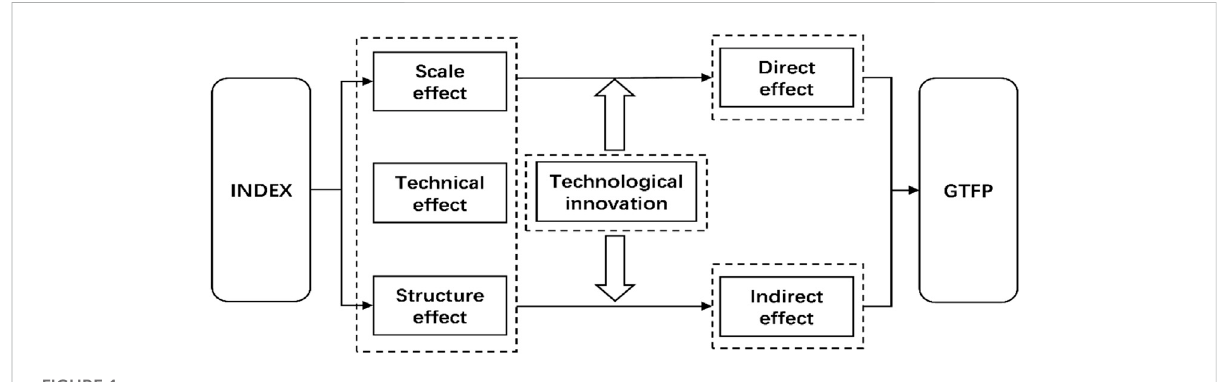
FIGURE 1 Theoretical mechanism